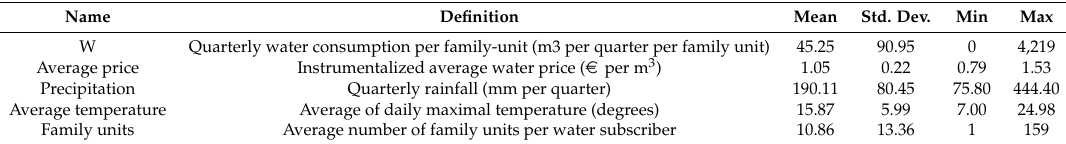
Table A1. Description of data used for estimating the domestic water demand